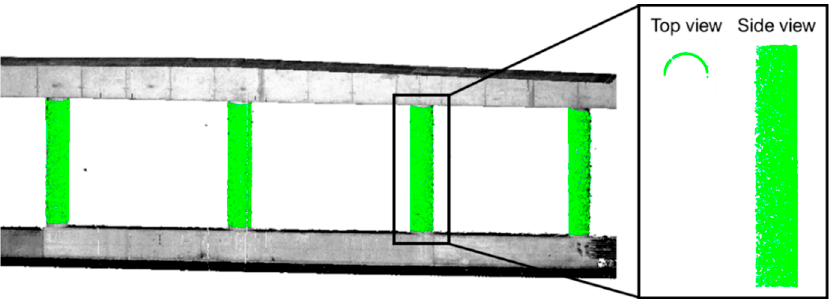
Figure 6. An example of cylindrical features (in green) that have been segmented from a LiDAR point cloud (colored by intensity).